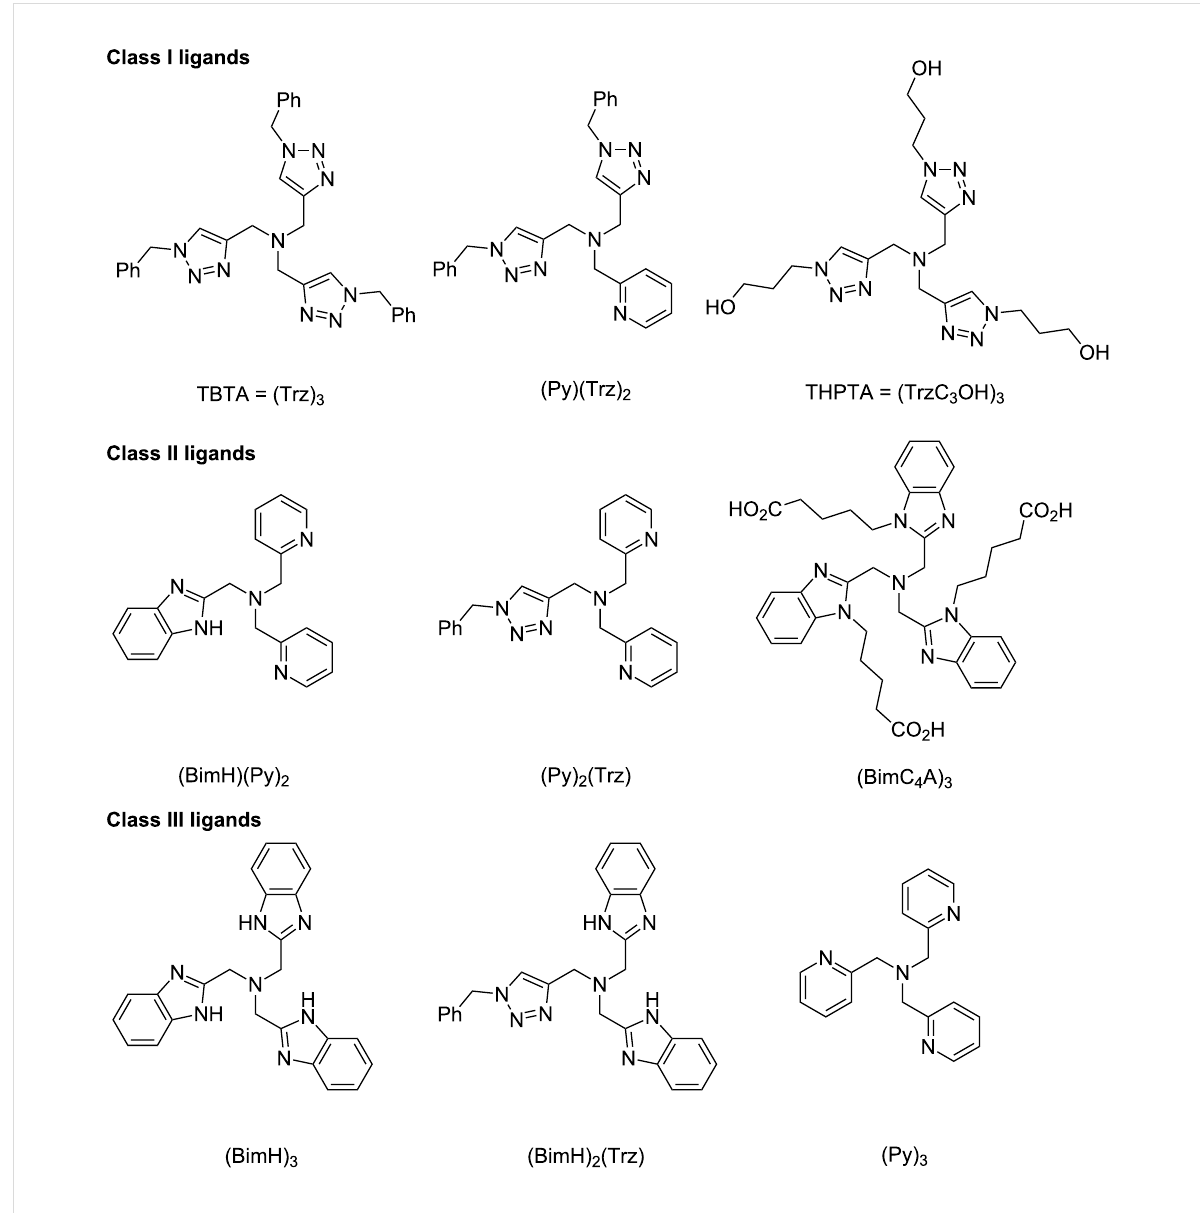
Figure 6: Categories of tris(heteroarylmethyl)amine ligands regarding their binding ability to copper(I) ions [83].